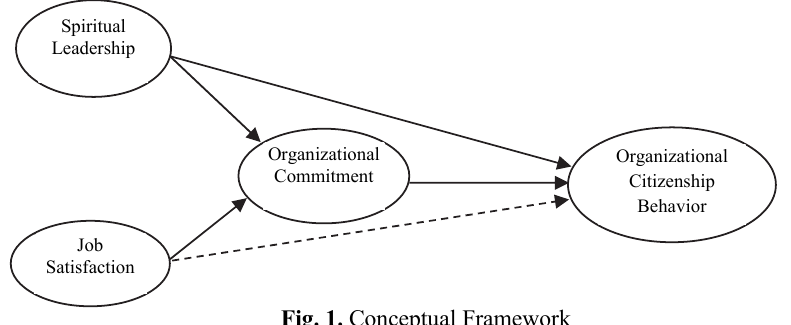
Fig. 1. Conceptual